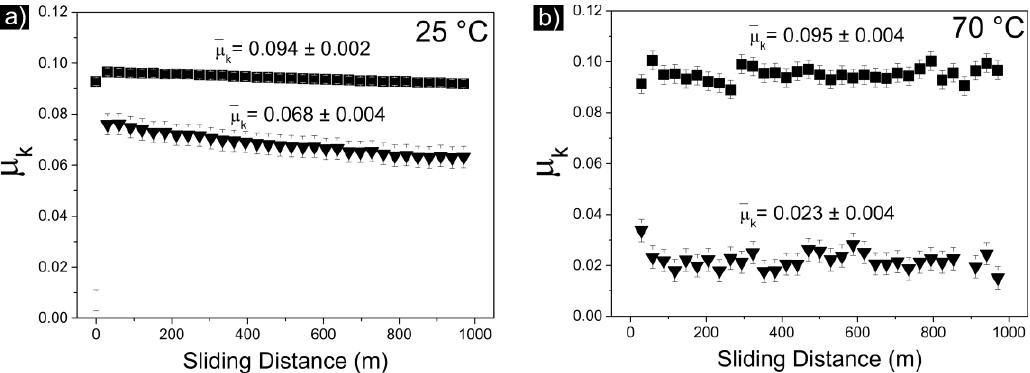
Figure 5. Kinetic friction coefficient (μ k ) evolution vs. sliding distance of AISI 4140—WC by using Castor ( ▼ ) and Reference ( ■ ) oil at ( a ) 25 °C and ( b ) 70 °C.